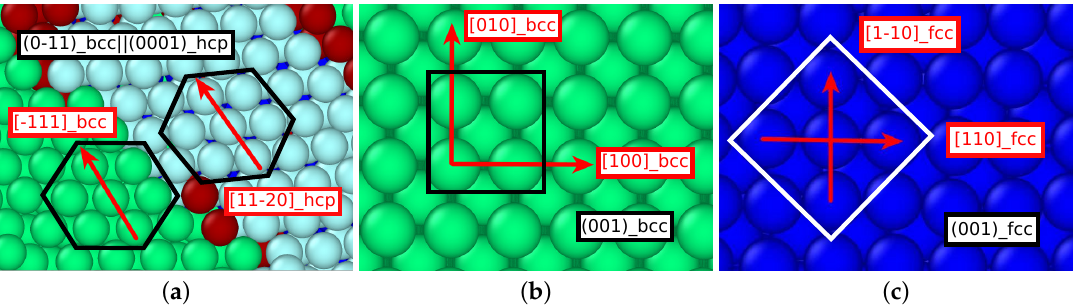
Figure 7. Pathway during the austenitic transformation of a sample with a dislocation density of 1.72 × 10 12 cm − 2 ; cf. Figure 4. Snapshot ( a ) during the phase transition at 728 K (corresponding